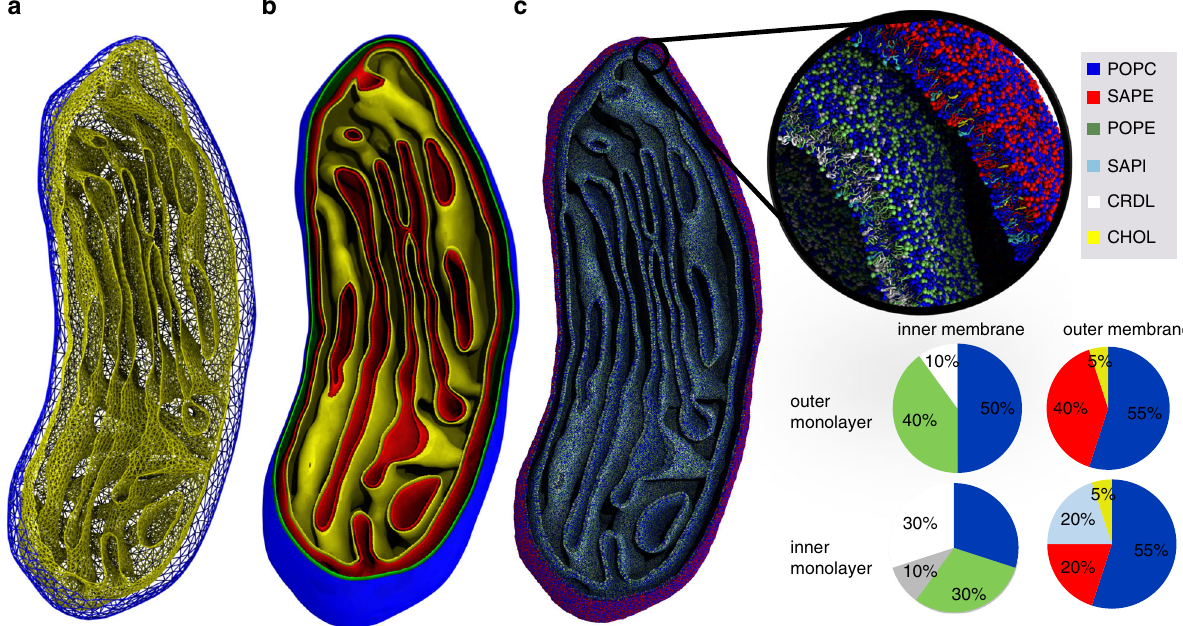
Fig. 5 Transformation of mitochondrial membranes to near-atomic resolution. a Cross section of the triangulated surfaces obtained from the EM map, separating outer (blue) and inner (yellow) membranes. b Cross section of the generated surface points for the outer monolayer of outer membrane (blue), inner monolayer of outer membrane (green), outer monolayer of inner membrane (red), and inner monolayer of inner membrane (yellow). c Backmapped structure after a 2 ns MD simulation with the Dry Martini force fi eld. The zoomed views show the different lipid types, the overall composition is speci fi ed in the pi charts. POPC 1-palmitoyl-2-oleoyl-sn-glycero-3-phosphocholine, POPE 1-palmitoyl-2-oleoyl-sn-glycero-3-phosphoethanolamine, SAPE 1-stearoyl- 2-arachidonoyl-sn-glycero-3-phosphoethanolamine, SAPI 1-stearoyl-2-arachidonoyl-sn-glycero-3-phosphoinositol, CHOL cholesterol, CRDL